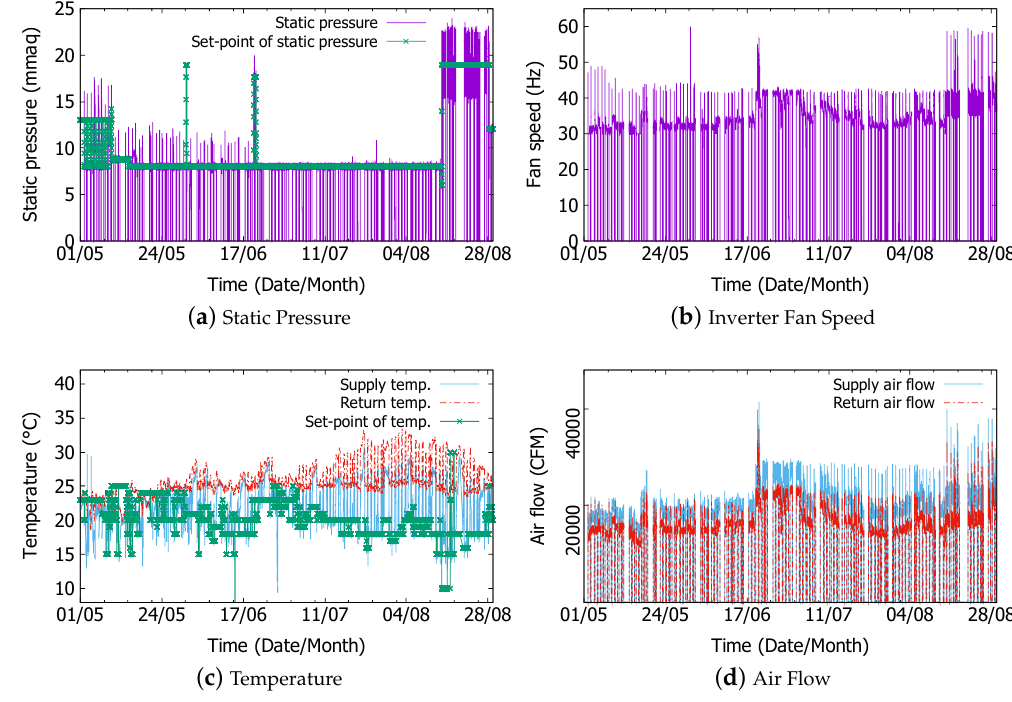
Figure 5. The 4th floor data